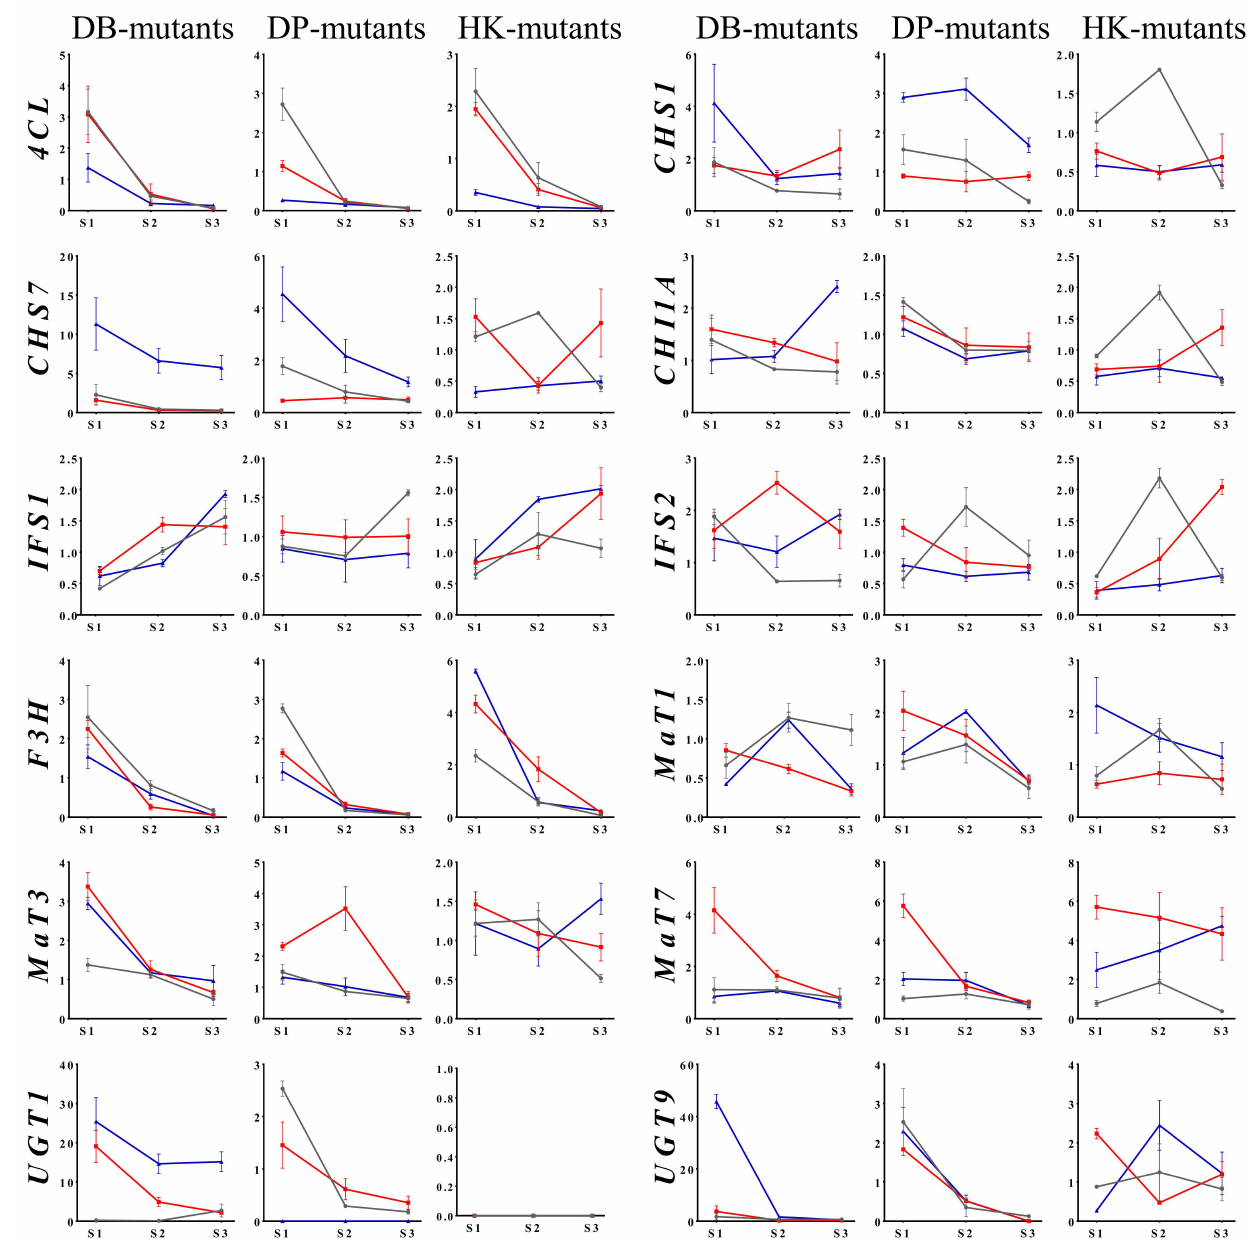
Figure 2. Relative expression level of isoflavone biosynthesis genes in seeds of soybean ‘Danbaek-mutants’ (Black line, DB; red line, DB-088; blue line, DB-064), ‘Daepung-mutants’ (Black line, DP; red line, DP-084; blue line, DB-093), and ‘Hwangkeum-mutants’ (Black line, HK; red line, HK-17; blue line, HK25-165) MDP lines at three developmental stages. Expression levels were estimated using quantitative real-time PCR analysis. The relative expression level was normalized to the internal reference gene ELF1B